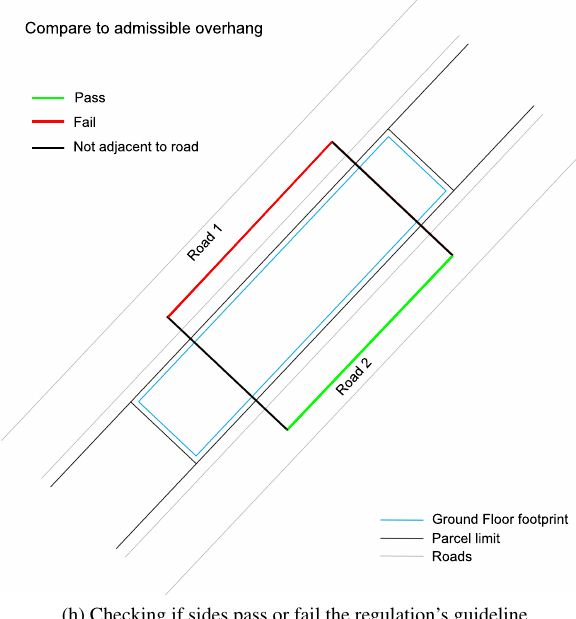
Figure 1. Steps to automatically check the overhang over